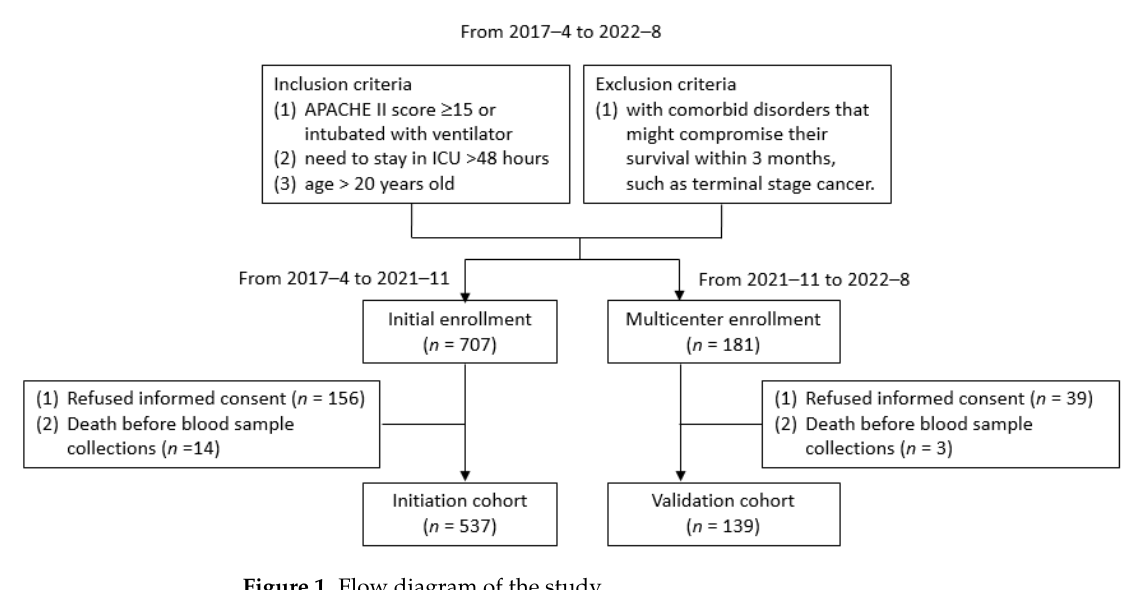
Figure 1. Flow diagram of the study.